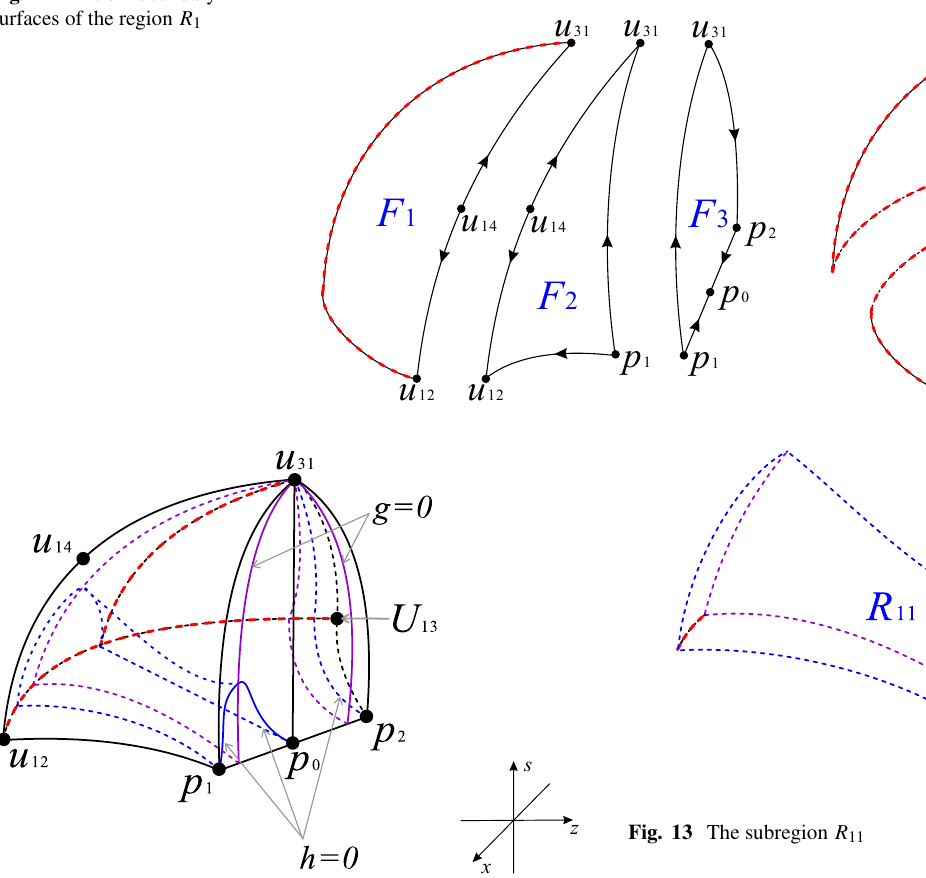
Fig. 11 The six boundary